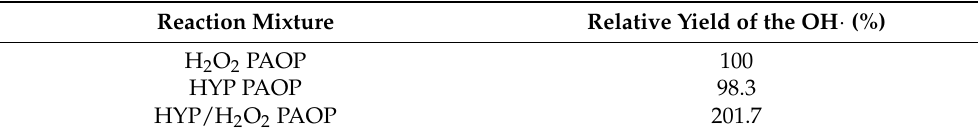
Table 2. The performance of the PAOP system proposed in the work and previous work.